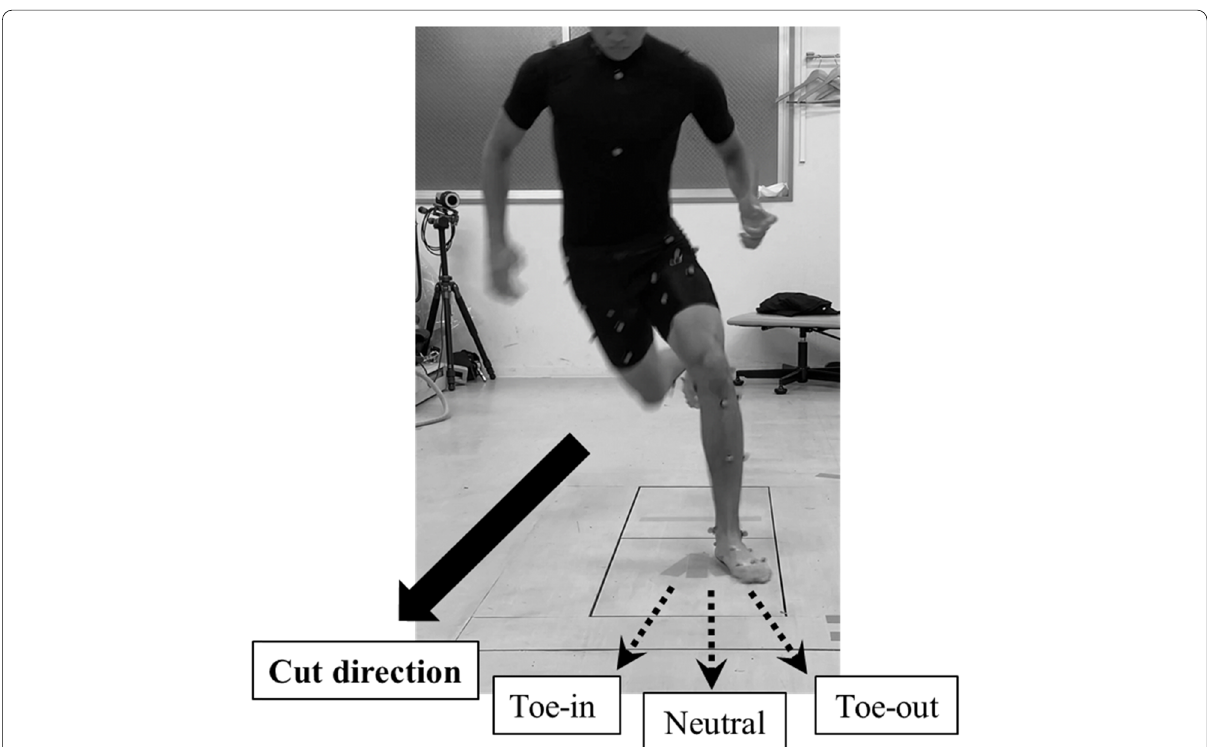
Fig. 1 Participants perform cutting maneuver on nondominant leg under toe-in, neutral, and toe-out landing. The peak values within the 40% stance phase equivalent to the loading acceptance and value at the timing of the peak Fz were compared among the neutral, toe-out, and toe-in